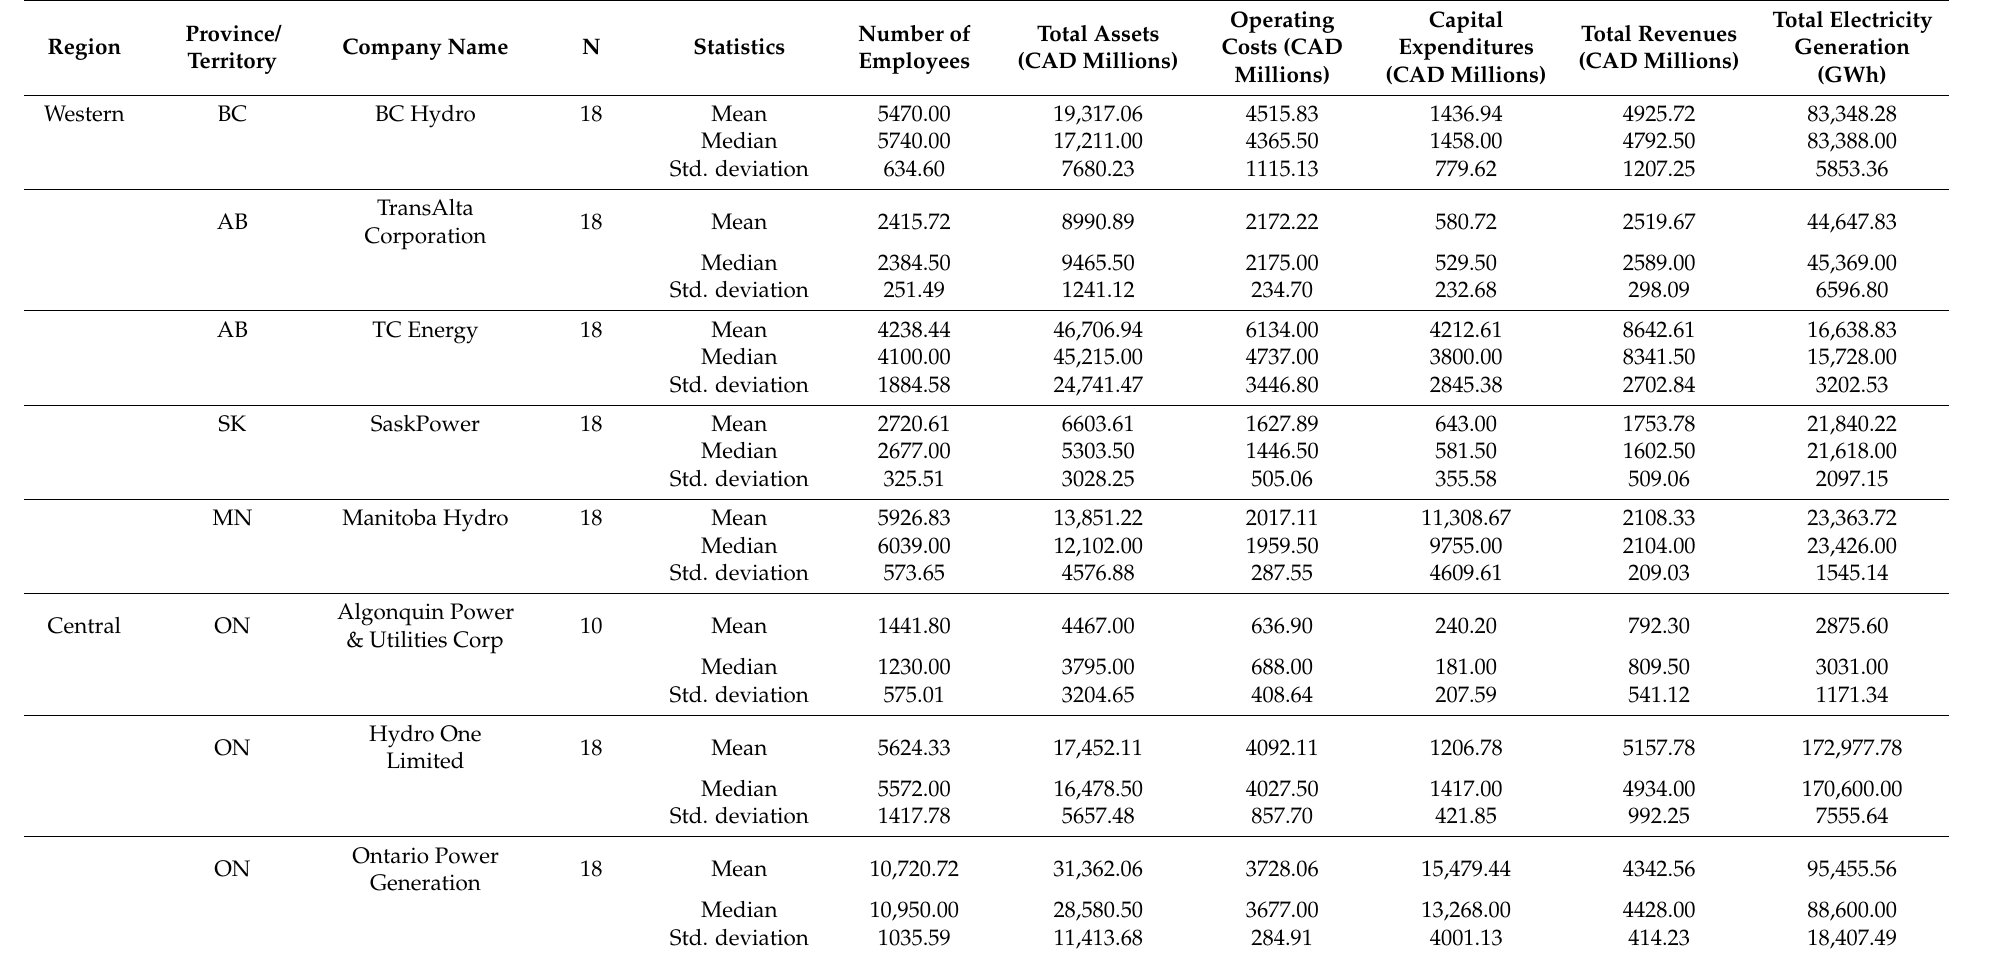
Table 2. Statistics pertaining to the inputs–outputs for the 17 power-generating